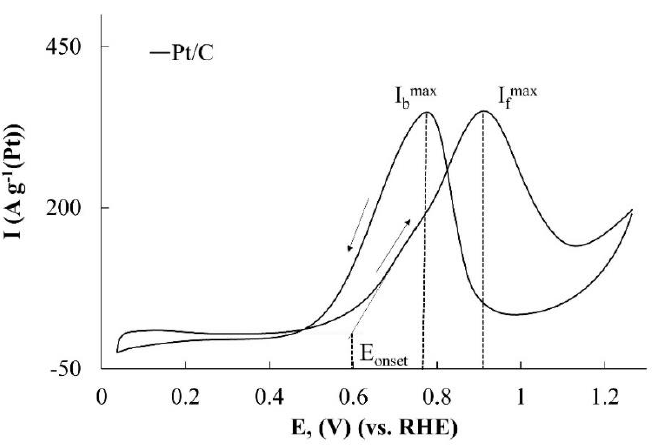
Figure 4. Cyclic voltammograms of methanol oxidation on Pt/C catalyst.